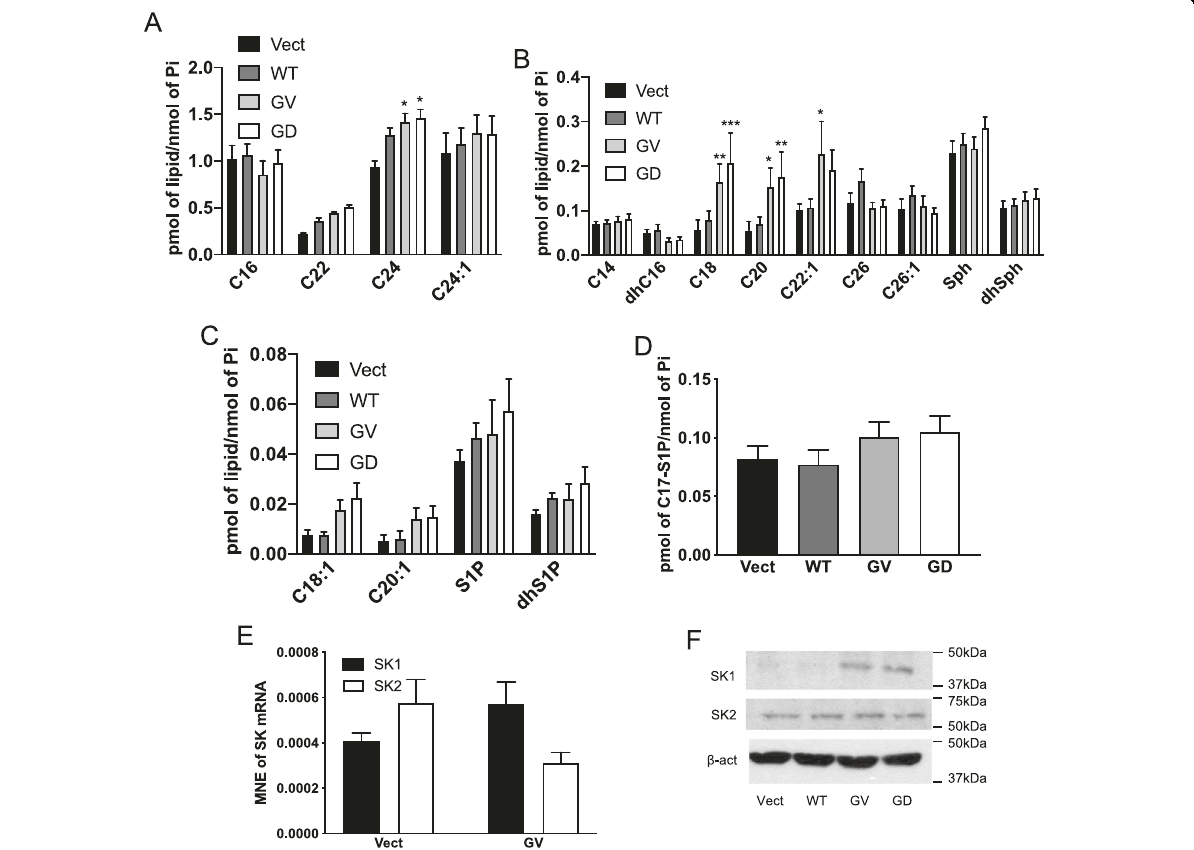
Fig. 3 Oncogenic K-Ras overexpression increases long-chain and very-long-chain Cer and SK1 protein levels. A – C SL analysis using tandem LC/MS/MS in cells overexpressing Vect or WT or mutant K-Ras. Cells were plated for 48 h and then scraped in a lipid extraction buffer. SL levels were quanti fi ed and normalized to the amount of total lipid phosphate. SL was organized according to their amounts in the cells, from the most abundant in ( A ) to the less abundant in ( C ). Panel B shows the SL having intermediate levels in the cells ( N = 6, data are presented as mean ± SEM, two-way ANOVA with Dunnett ’ s multiple comparisons test, * means p < 0.05 comparing the tested groups to the group control Vector). D Determination of SK activity using labeling with C17-Sph. Cells were plated and incubated for 48 h and then C17-Sph (250 nM) was added for 1 h and then the cells were scraped in the lipid extraction buffer and the samples were analyzed ( N = 4, data are presented as mean ± SEM, one-way ANOVA with Dunnett ’ s multiple comparisons test, * means p < 0.05 comparing the tested groups to the group control Vector). E Analysis of SK mRNA levels using RT-qPCR in cells overexpressing Vect or GV K-Ras. Cells were plated and kept in culture for 48 h then scraped and RNA extraction was performed on the cell pellets using a kit. Another kit was used to synthesize cDNA using 1 µg of RNA. cDNA was then diluted and used as a template for RT-qPCR. SK1, SK2, and Actin TaqMan probes were used. The mean normalized expression of SK1 and SK2 was determined by using the Ct values ( N = 4, data are presented as mean ± SEM, two-way ANOVA with Tukey ’ s multiple comparisons test, * means p < 0,05 comparing all the groups). F Western blot analysis of SK1 and SK2 protein expression in cells overexpressing Vect or WT or mutant K-Ras after 48 h in